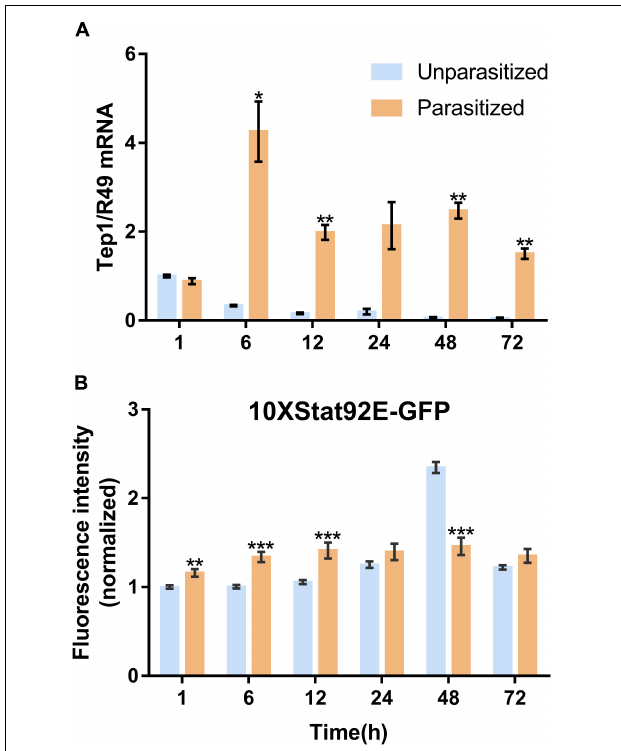
FIGURE 7 | Effects of parasitism on the JAK/STAT pathway. (A) mRNA expression levels of Tep1 at 1, 6, 12, 24, 48, and 72 h both in parasitized and unparasitized Drosophila ( n = 3), and R49 was used as internal reference. (B) Fluorescence intensity analysis of 10 ∗ Stat92E-GFP Drosophila both in parasitized and unparasitized based on the time points mentioned above ( n ≥ 10), and the fluorescence intensity of 1 h unparasitized was normalized to 1. The results are shown as the mean ± standard error; ∗ P < 0.05, ∗∗ P < 0.01, and ∗∗∗ P < 0.001 compared to unparasitized.